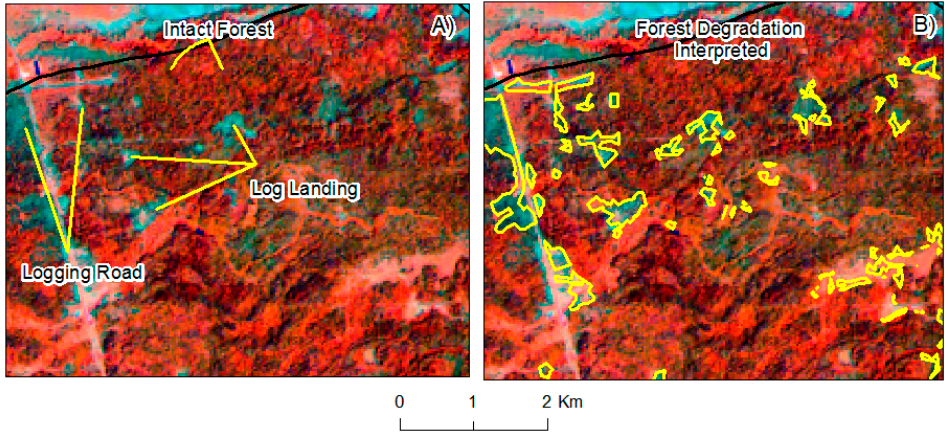
Figure 4. Detection of forest roads, logging yards and intact forests ( A ); and interpretation of forest degradation ( B ) for the 1990–2000 period in a 2000 Landsat image.